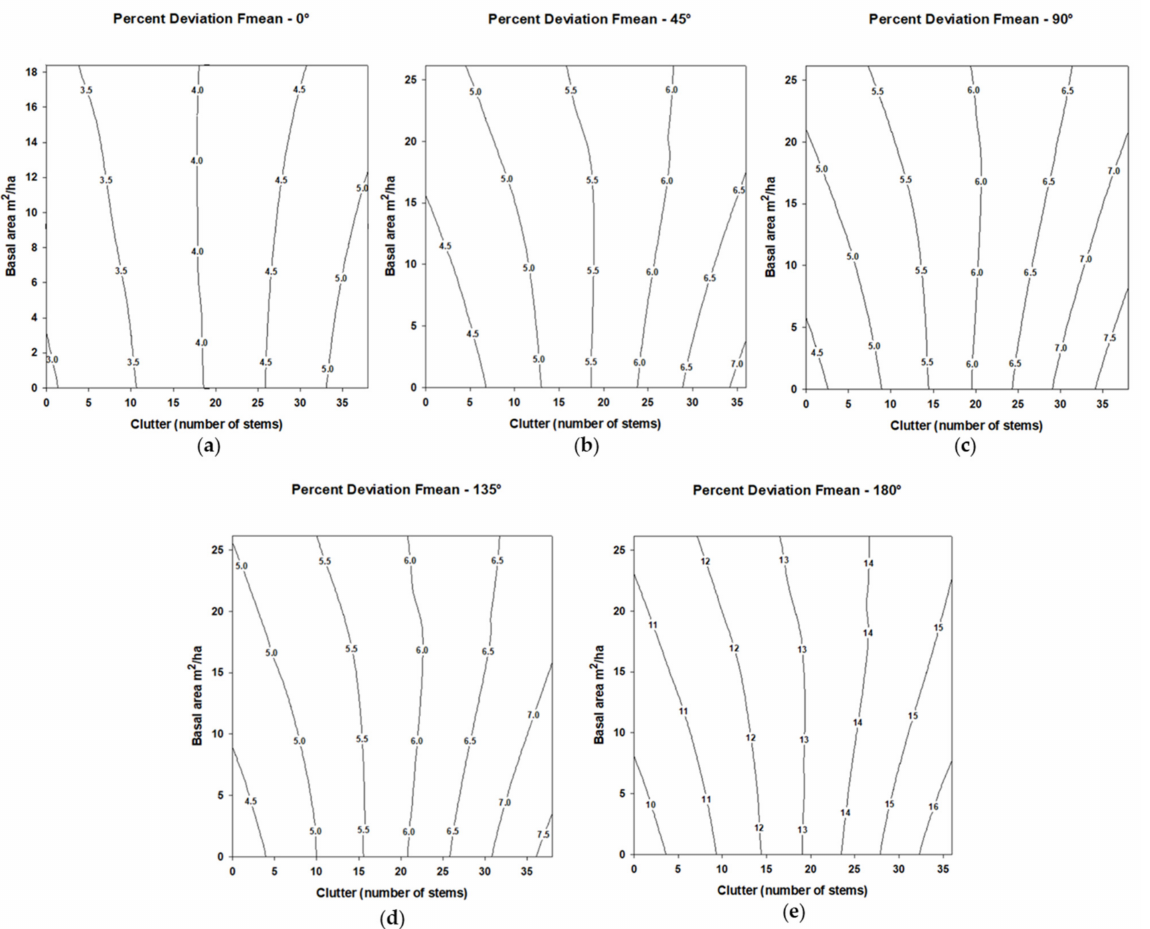
Figure 5. Contour graph for generalized linear model results of synthetic bat echolocation playback response within an anechoic chamber displaying the percent deviation on the mean frequency (Fmean) call parameter in relation to stem density (stem count) and basal area (m 2 /ha) for detector angles ( a ) 0 ◦ , ( b ) 45 ◦ , ( c ) 90 ◦ , ( d ) 135 ◦ , and ( e ) 180 ◦ , Blacksburg, VA, USA, 2016 (see text for